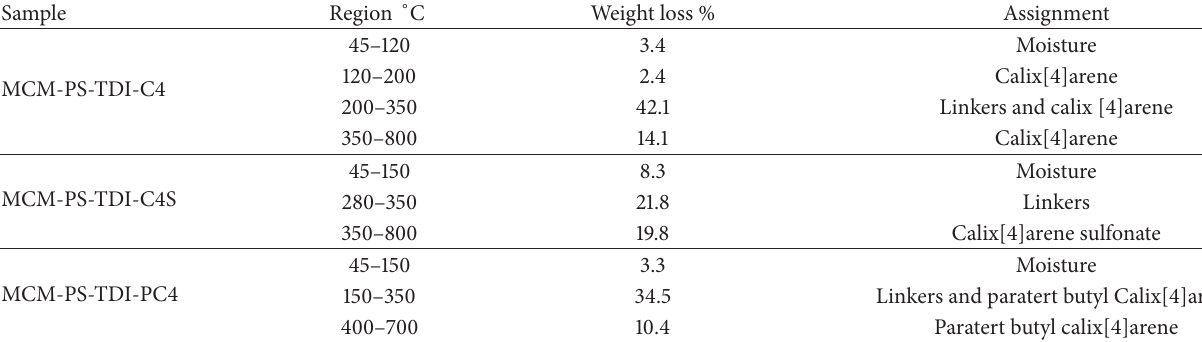
Table 2: Results of thermogravimetric analysis.